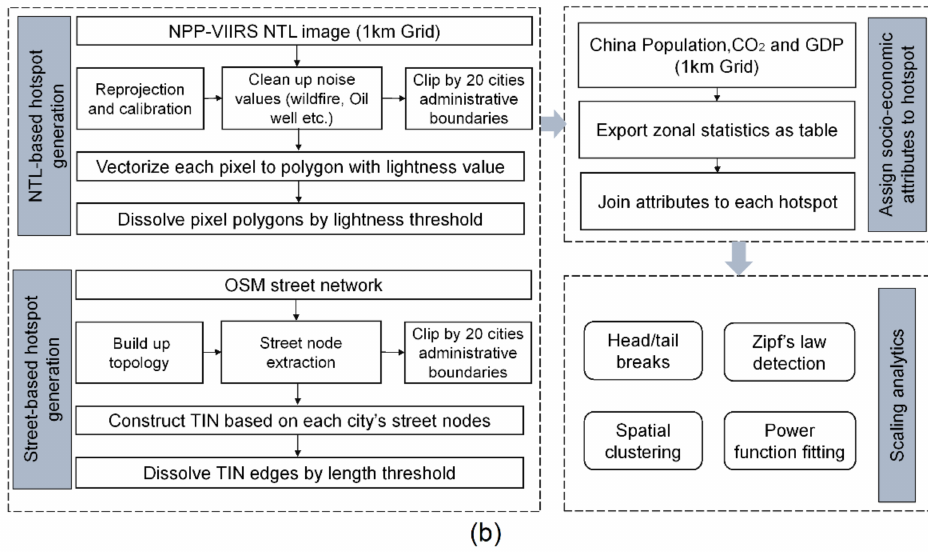
Figure 1. (Color online) The related datasets ( a ) and the methodological framework ( b ) in this study. (Note: The units of raster datasets for population, GDP, CO 2 emissions are 1 person/km 2 , 10,000 CNY/km 2 , and 10,000 ton/km 2 ,